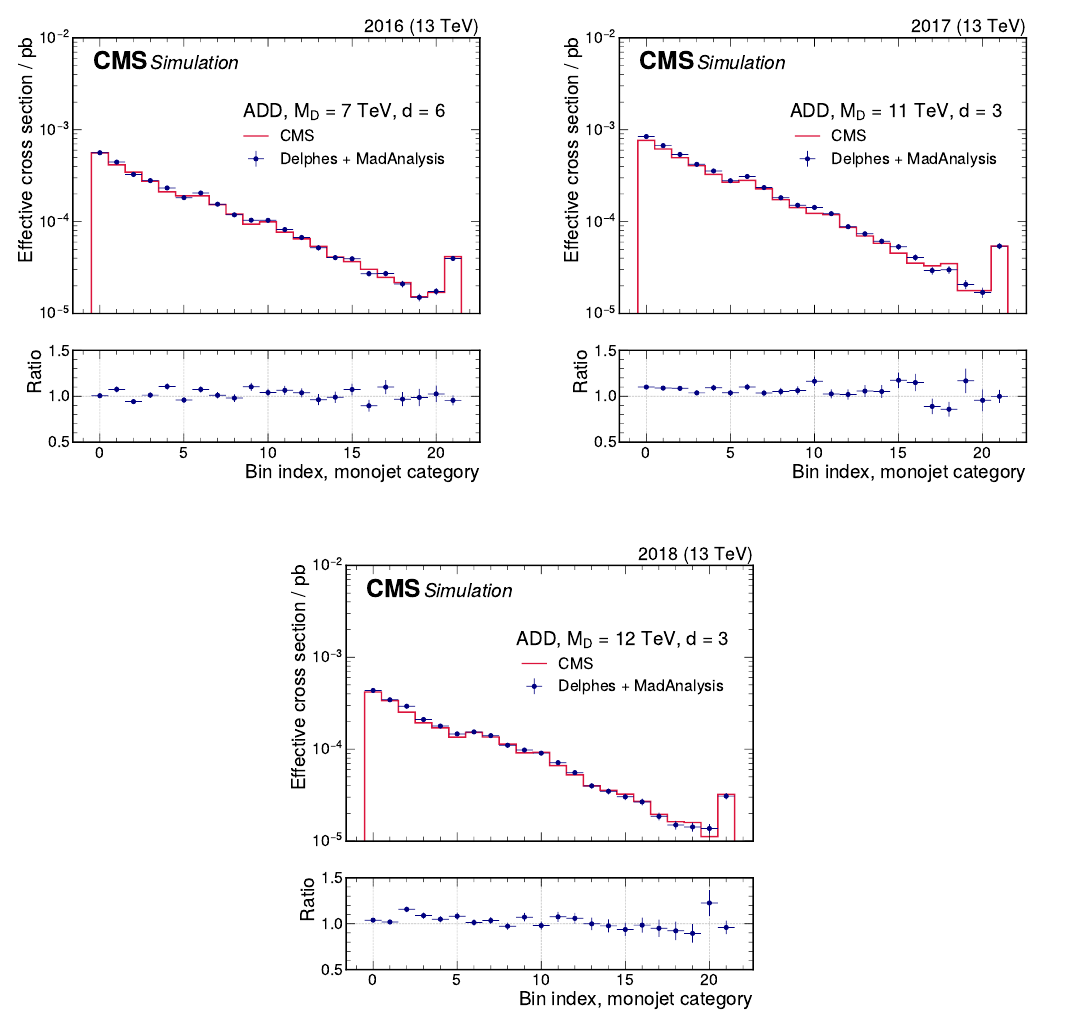
Figure 26 . Comparison of the signal templates derived with Delphes and MadAnalysis (dark blue points) and the CMS analysis work flow (red solid line). The panels show three example parameter points for the ADD interpretation, and showcase the selection procedure for different years (2016 in the upper left, 2017 in the upper right, and 2018 in the lower panels). The rightmost bin includes the overflow. In all cases, the average agreement is observed to be better than 10% , with maximum deviations up to 20% in single